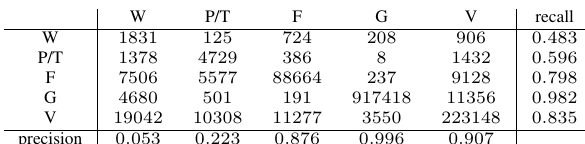
Table 2: Confusion matrix resulting from SVM-based classifica- tion with only the five best-ranked features. The overall classifi- cation accuracy is 93 . 32% .